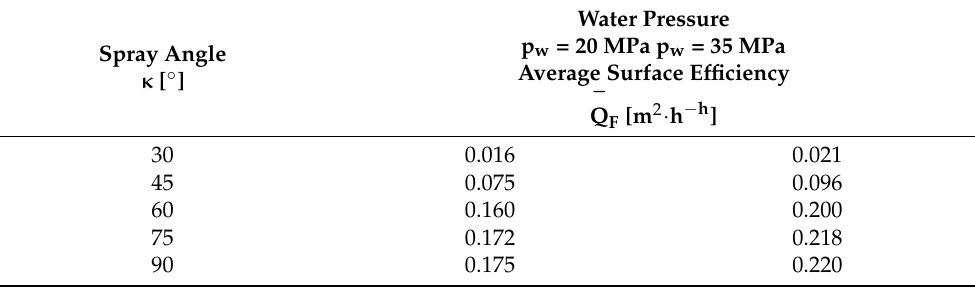
Table 17. Measuring results of average surface paint coat stripping efficiency Q F [m 2 · h − 1 ] of PA2 aluminium alloy specimen depending from spray angle κ [ ◦ ].